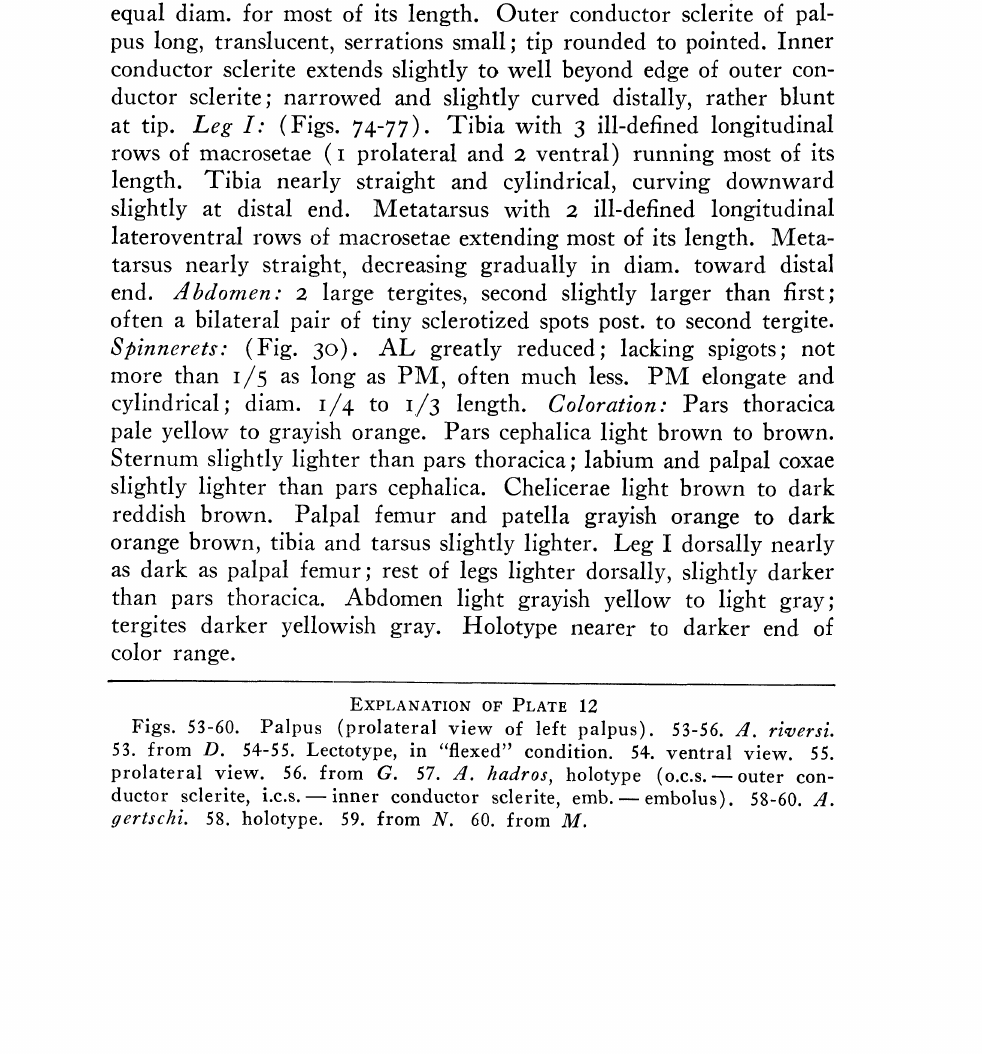
Male. Carapace: (Figs. 9, 21 ). Elongate oval. Thoracic groove narrow for entire length; center of thoracic groove less than 2/3 distance from ant. to post. border of carapace. Setae scattered over entire pars thoracica, densest at lateral edges.. Setae rare to, absent at base of pars cephalica, becoming numerous higher up. Pars cepha- lica weakly elevated, highest at eye group. Height of clypeus at ALE to I/2 times vertical diam. of ALE. Diam. of AME 2/3 to slightly greater than their distance apart. Sternum: (Fig. 35). Elongate. 3 post. pairs of sigilla oval. Chelicerae: (Figs. 9, 5o-52). Apophysis moderately to. very thick; curving downward distally. All apophyseal setae attenuate, post. ones stronger than ant. ones. Pedi- palps: (Figs. I5, 58-60’) Tibia swollen in cylindrical form, of nearly equal diam. for most of its length. Outer conductor sclerite of pal- pus long, translucent, serrations small; tip rounded to pointed. Inner conductor ,sclerite extends slightly to well beyond edge of outer con- ductor sclerite; narrowed and slightly curved distally, rather blunt at tip. Leg I: (Figs. 74-77). Tibia with 3 ill-defined longitudinal rows of macrosetae (I prolateral and 2 ventral) running most of its length. Tibia nearly straight and cylindrical, curving downward slightly at distal end. Metatarsus with 2 ill-defined longitudinal lateroventra,1 rows o macro.setae extending most of its length. Meta- tarsus nearly straight, decreasing gradually in diam. toward distal end. Abdomen: 2 large, tergites, second slightly larger than first; often a bilateral pair of tiny sclerotized spots post. to second tergite. Spinnerets: (Fig. 3o). AL greatly reduced; lacking spigots; not more than 1/5 as long as PM, often much less. PM elongate, and cylindrical; diam. 1/4 to I./3 length. Coloration: Pars thoracica pale yellow to grayish orange. Pars cephalica light brown to brown. Sternum slightly lighter than pars thoracica; labium and palpal coxae slightly lighter than pars cephalica. Chelicerae light brown to dark reddish brown. Palpal femur and patella grayish orange to, dark orange brown, tibia and tarsus slightly lighter. Leg I dorsally nearly as dark as palpal femur; rest of legs lighter dor,sally, slightly darker than pars thoracica. Abdomen light grayish yellow to light gray; tergites darker yellowish gray. Holotype nearer to darker end of color